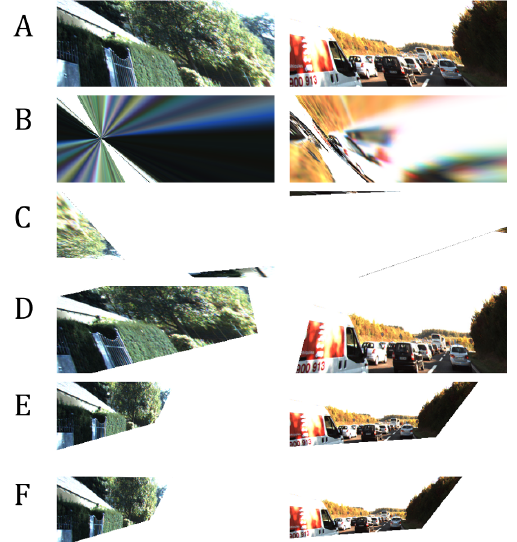
Figure 9. Our network is robust and can still produce a correct image even on extremely distorted images such as when majority of pixels are out of bounds. ( A ): Distorted input images. ( B ): Corrected image using homography estimation ( C ): Corrected image using the technique of Chaudhury et al. [21]. ( D ): Corrected image using the technique of Li et al. [11]. ( E ): Corrected image using our method. ( F ):